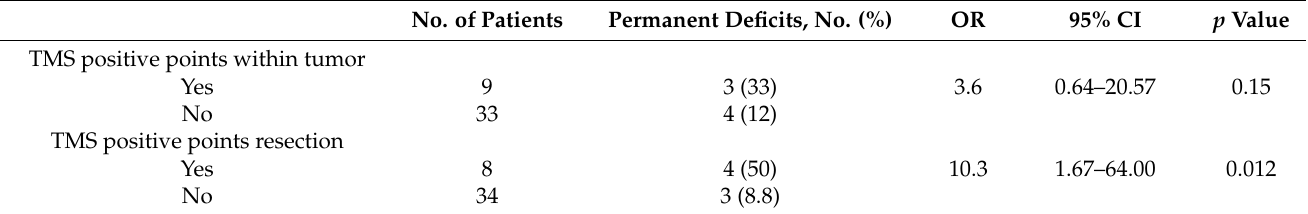
Table 2. Univariate binary logistic regression for predication of permanent deficit from cortical TMS perioperative variables.